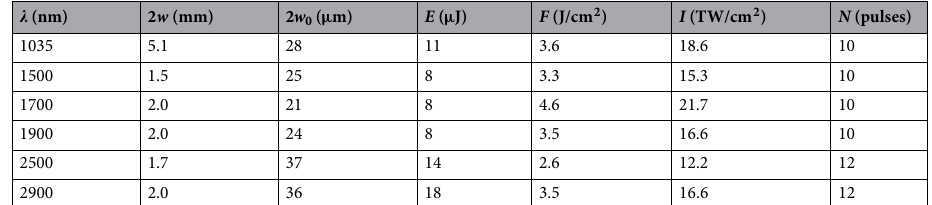
Table 1. Summary of the experimental parameters: (cid:31) is the pulse central wavelength, 2 w is the beam diameter on a focusing lens, 2 w 0 is the estimated diameter of the focal spot, E is the pulse energy, F is the peak fluence, I is the peak intensity and N is the number of pulses.